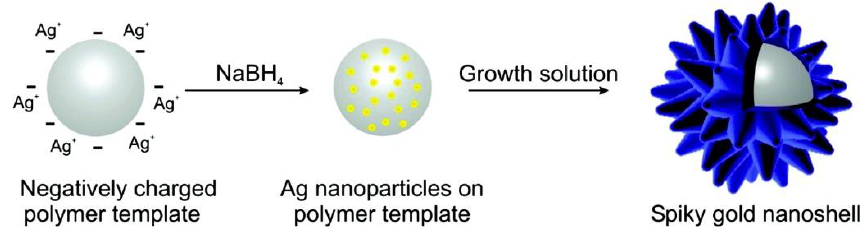
Figure 17. Spiky gold nanoshells synthesis. Reprinted with permission from Reference [118]. Copyright (2012) American Chemical Society.